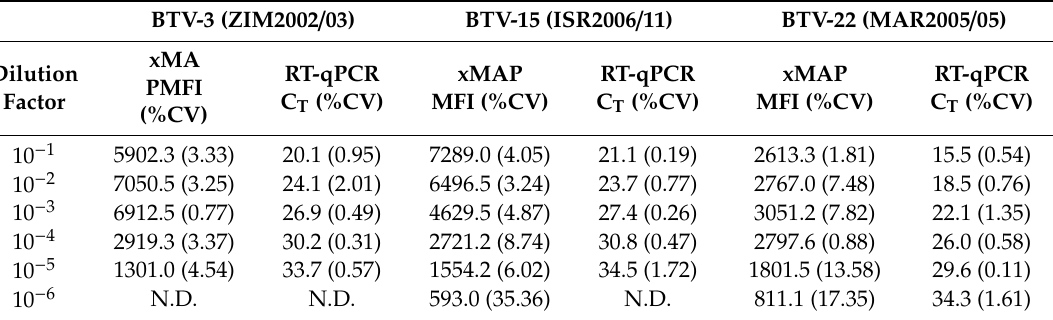
Table 4. Analytical sensitivity for the BTV xMAP